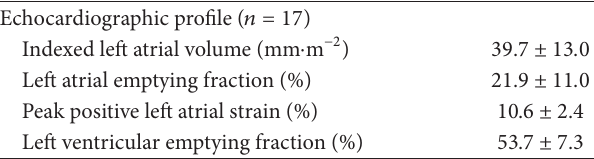
Table 3: Echocardiographic profile of the study